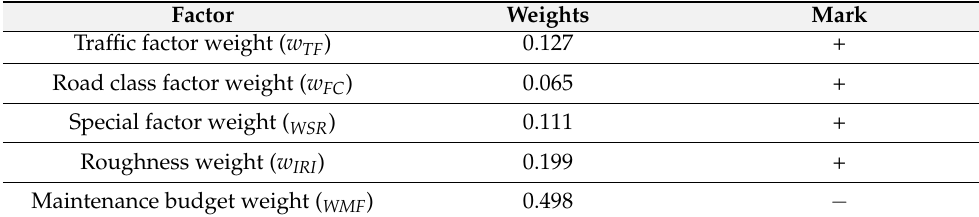
Table 4. Weight factors for